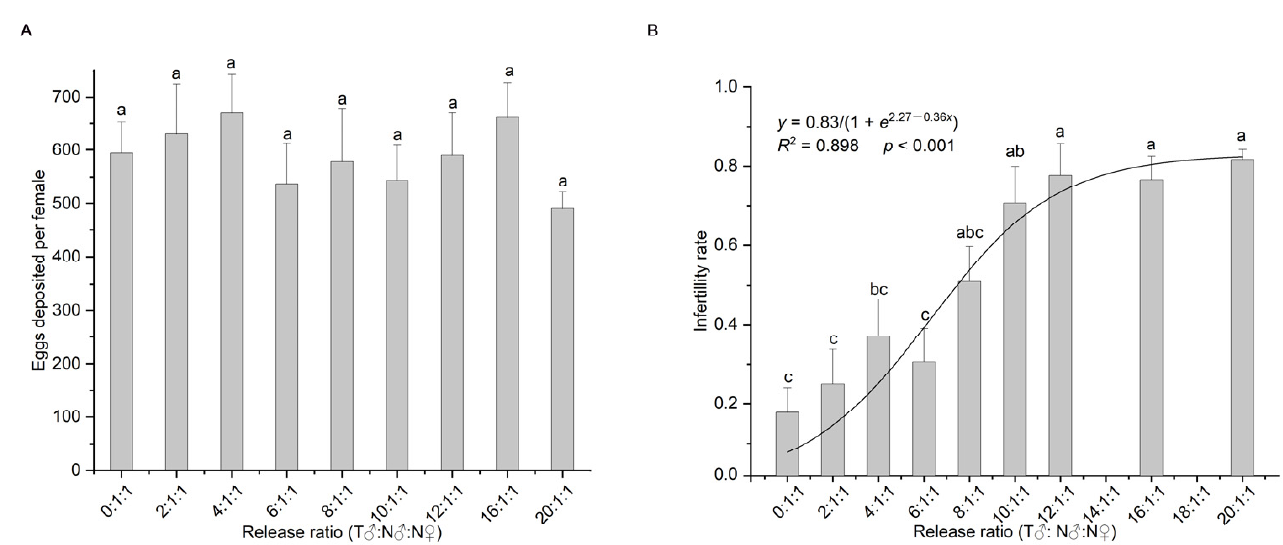
Figure 1. Average number of eggs laid per female ( A ), infertility rate (probability of non-hatching eggs) (mean ± standard error) and the fitting of the release ratio to the infertility rate (probability of non-hatching eggs) ( B ) in Spodoptera frugiperda at different release ratios; different lowercase letters indicate significant differences (one-way ANOVA, Tukey’s HSD; p < 0.05). T = treated with irradiation; N = not irradiated.